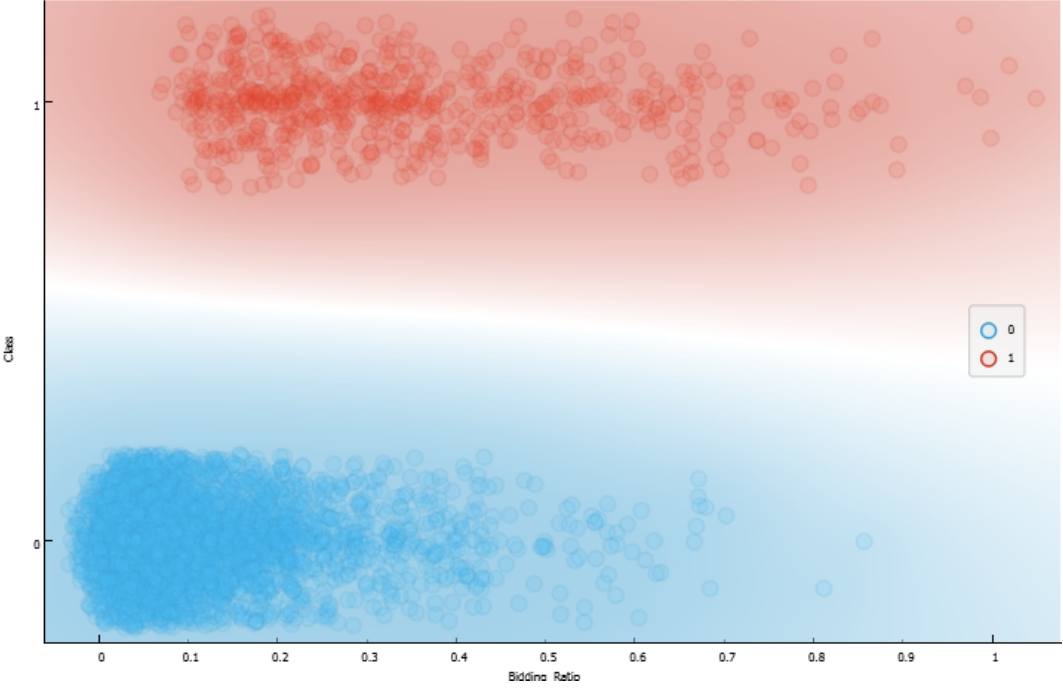
Figure 15. Scatter plot of bidding ratio feature.